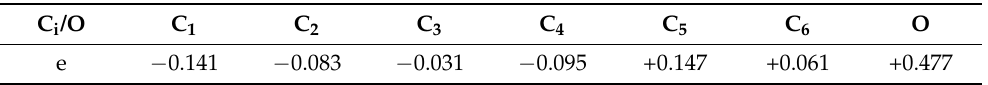
Table 2. The charge transfer of the atoms of biphenylene while O atom adsorbing at B 3 site. C i